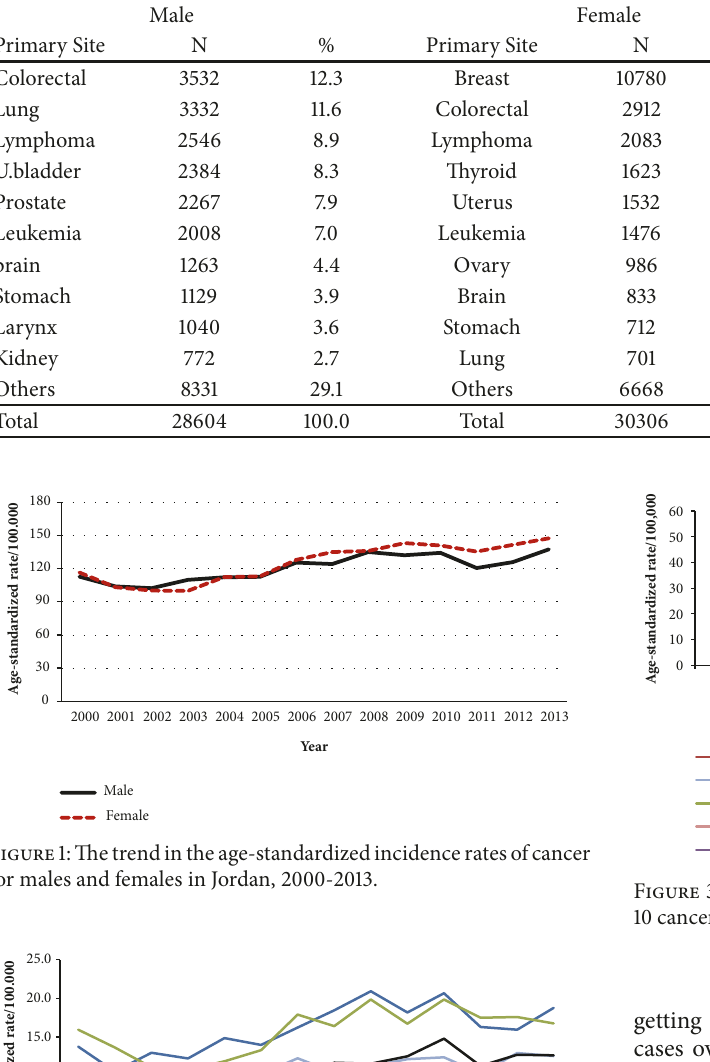
among Jordanians was 82.9 per 100,000 population (76.2 for males and 90.1 for females). The ASR was 142.1 per 100,000 population (137.4 for males and 147.5 for females).